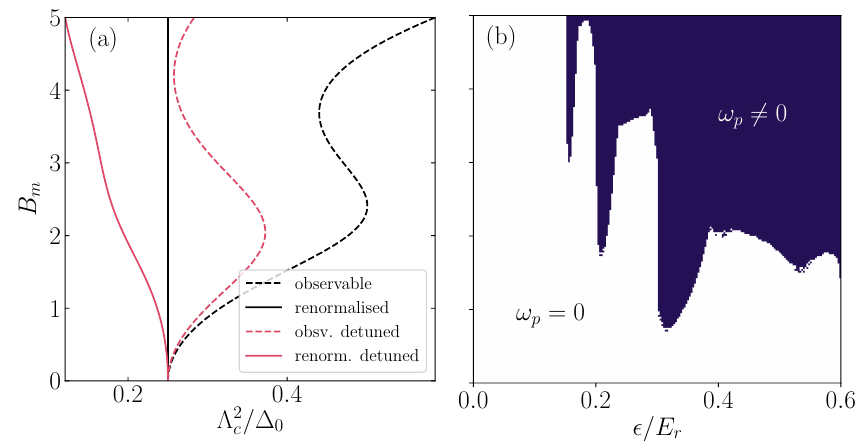
Figure 7: a) A plot of how the critical coupling strength Λ changes with the modula- c tion amplitude. The two different colors represent Ω = ω (black) and an effective T + 0.1 (red). The remaining parameters are the detuning between the modes Ω = ω T same as the ones used in Fig. 6. The dashed lines are obtained for the same systems but with the critical coupling strength being renormalized to make up for the lost power in the unused laser sidebands given by Eq. (15). b) Plot of the dominant in- stability of the system as a function of the PM parameters with the same parameters as in Fig. 6 but with κ = 0.05 E . In the white region the system experiences a tran- r sition to a superradiant phase at the finite critical coupling strength Λ . The colored c region indicates parameters where a finite-frequency instability takes